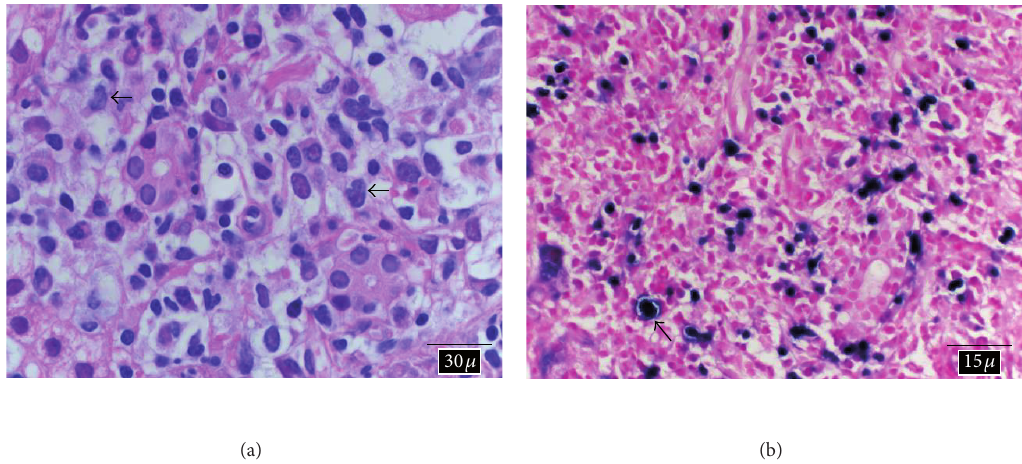
Figure 1: Liver biopsy: (a) high power view of H&E-stained section of liver core biopsy showing focally prominent mixed inflammatory cell infiltrate comprised of small lymphocytes, plasma cells, neutrophils, and rare large cells with irregular nuclear contours and prominent eosinophilic nucleoli. Arrows point to large atypical lymphocytes (100x magnification). (b) EBV in situ hybridization analysis for the detection of EBV-encoded RNA (EBER) reveals abundant positive cells with dark nuclear staining, consistent with EBV infection. Arrow points to a large atypical EBV-positive cell (50x magnification).